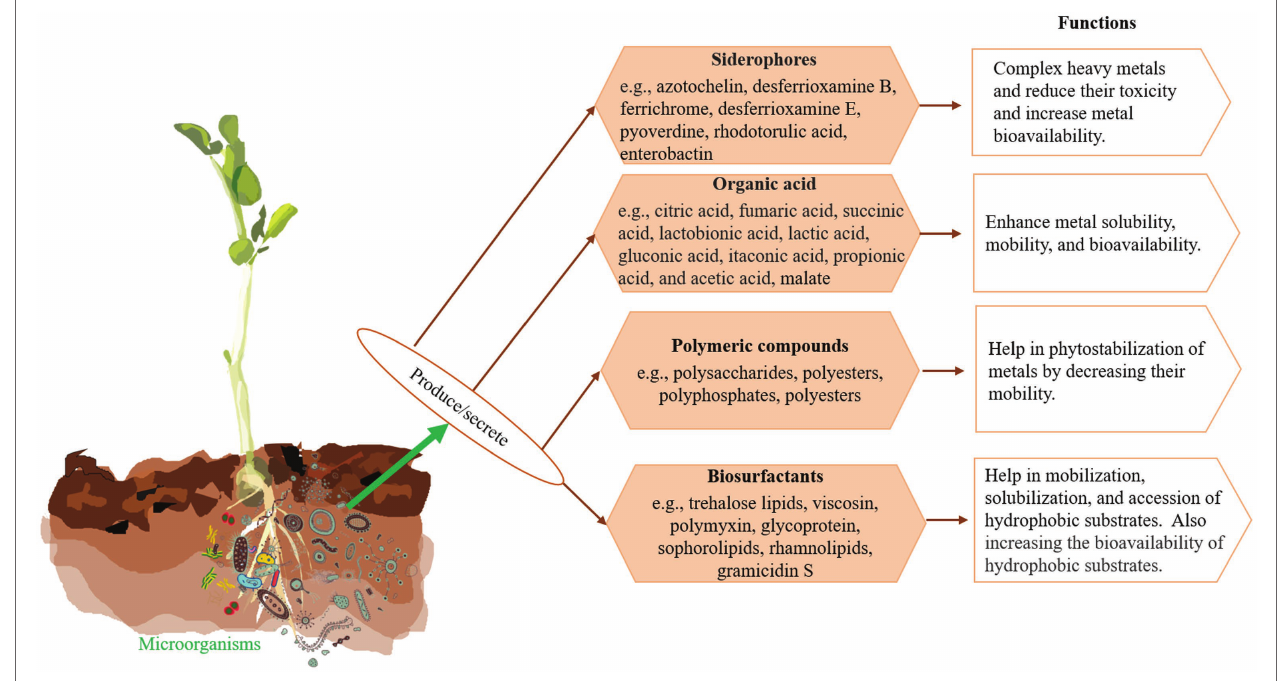
FIGURE 2 | Microorganisms produce/secrete different compounds and their role in